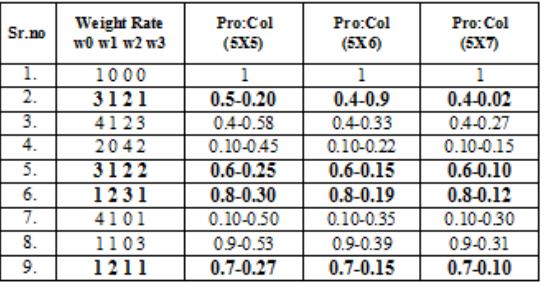
Table 1. Comparing probability of collisions with different time